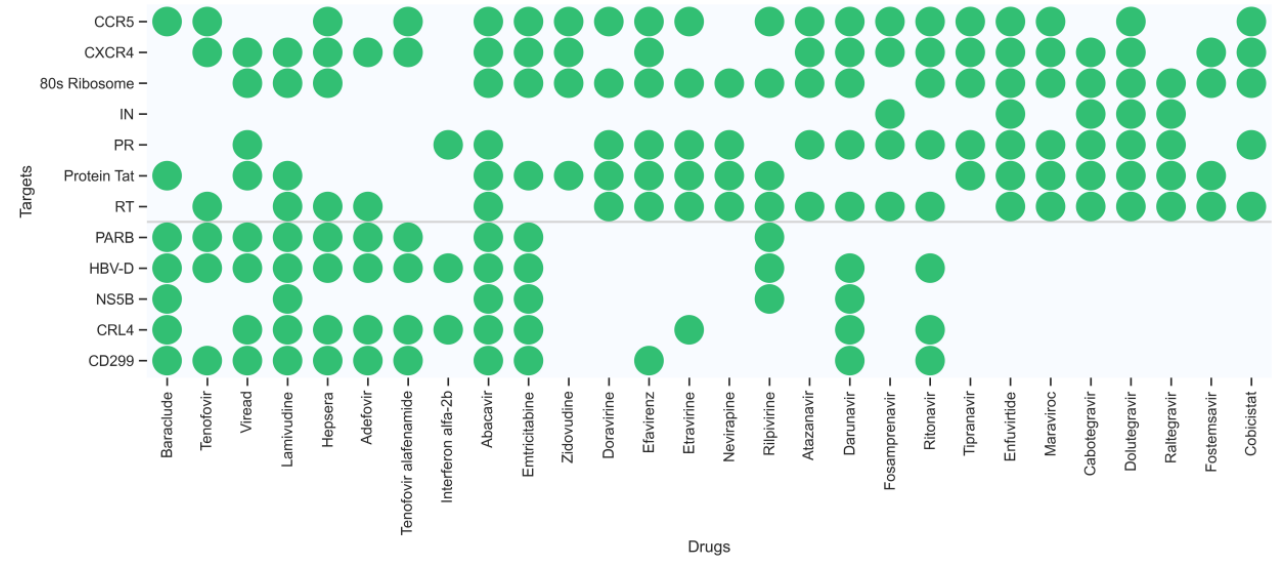
Table 2. Known experimental verification of approved HIV-1 and HBV drugs.